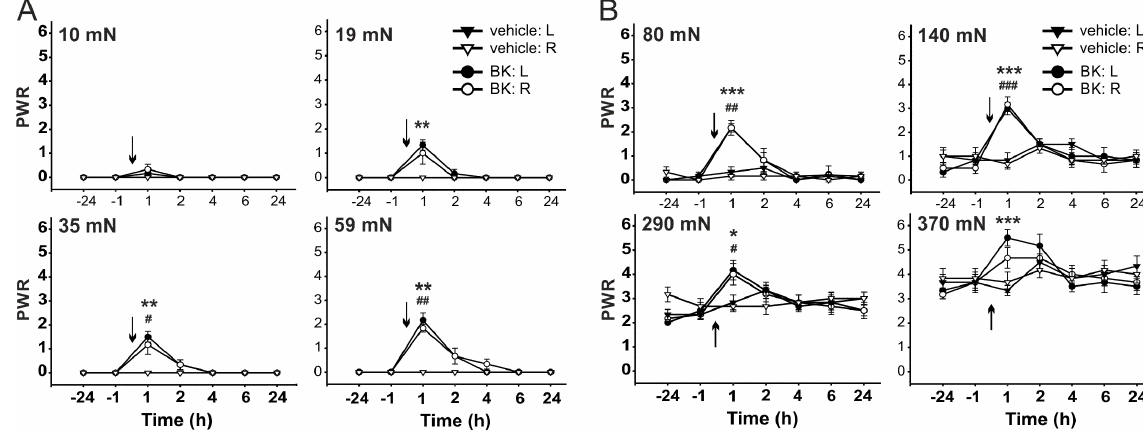
Figure 4. Intrathecal administration of BK evoked mechanical hypersensitivity. Administration of BK (21.2 µg, i.t., n = 6) evoked transient mechanical allodynia using von Frey filaments with bending forces 19 mN, 35 mN, and 59 mN ( A ), and hyperalgesia using filaments with bending forces 80 mN, 140 mN, and 290 mN ( B ). Data represent the mean ± S.E.M. of 6 (BK) and 6 (vehicle) independent experiments. Statistical analysis: Mann-Whitney rank test; * p < 0.05, ** p < 0.01, *** p < 0.001 left hindpaw, BK versus vehicle treatment; # p < 0.05, ## p < 0.01, ### p < 0.001 right hindpaw, BK versus vehicle treatment. The time of the i.t. administration is marked by arrows.